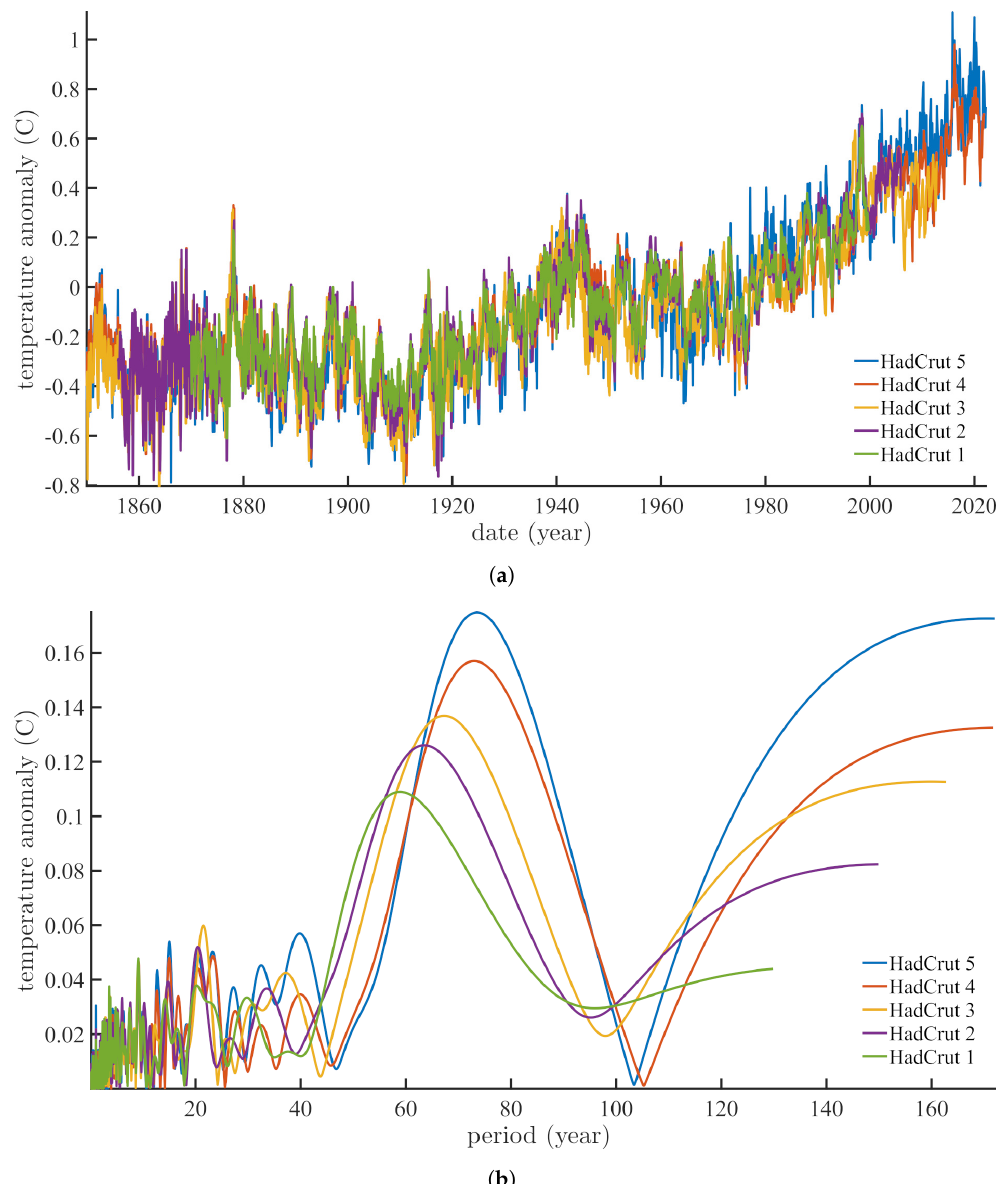
Figure 1. The five HadCrut mean global temperatures since 1850. ( a ) The five mean global tempera- ture data sets HadCrut1 to HadCrut5 from 1850 to the present maintained by the Hadley Center for Climate Prediction and Research (see text). ( b ) The 5 Fourier spectra of the 5 data sets in Figure